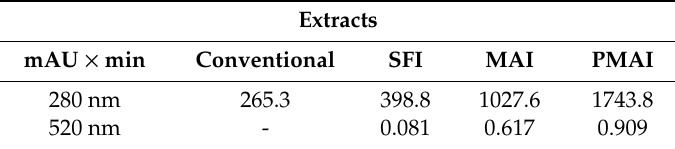
Table 1. Total area of peaks in the chromatograms corresponding to the extracts obtained using the di ff erent pretreatment procedures, at 280 nm for phenolic compounds and 520 nm for anthocyanins.